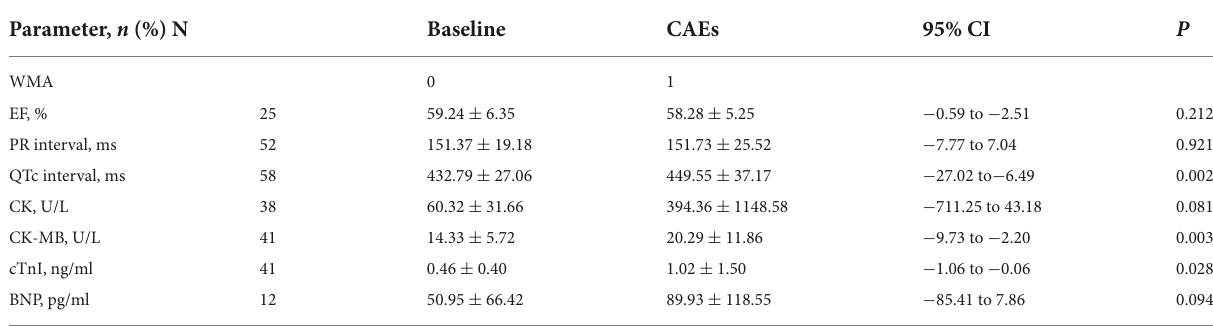
TABLE 2 The characteristics of biomarkers in patients with CAE ( n =